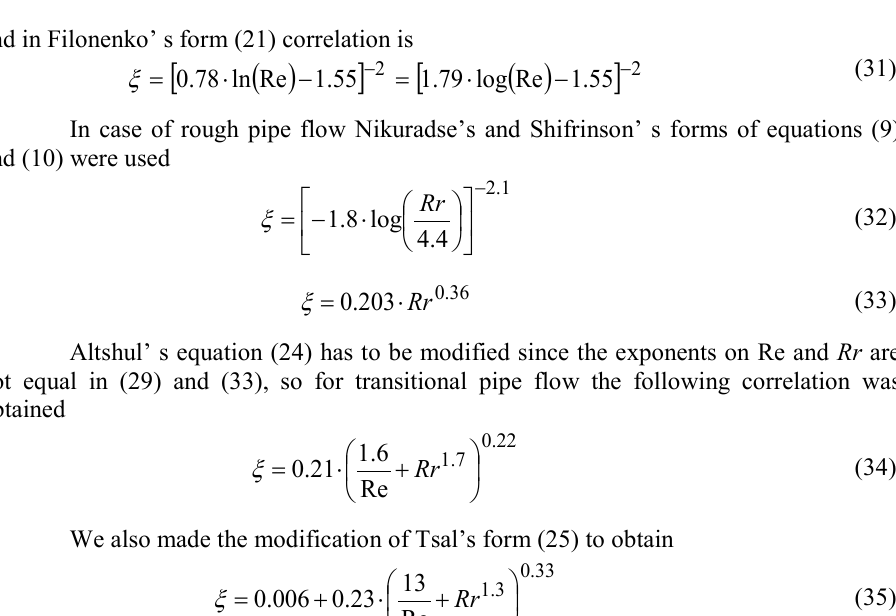
Table 4 Review of the correlations for turbulent transition pipe flow (database z =